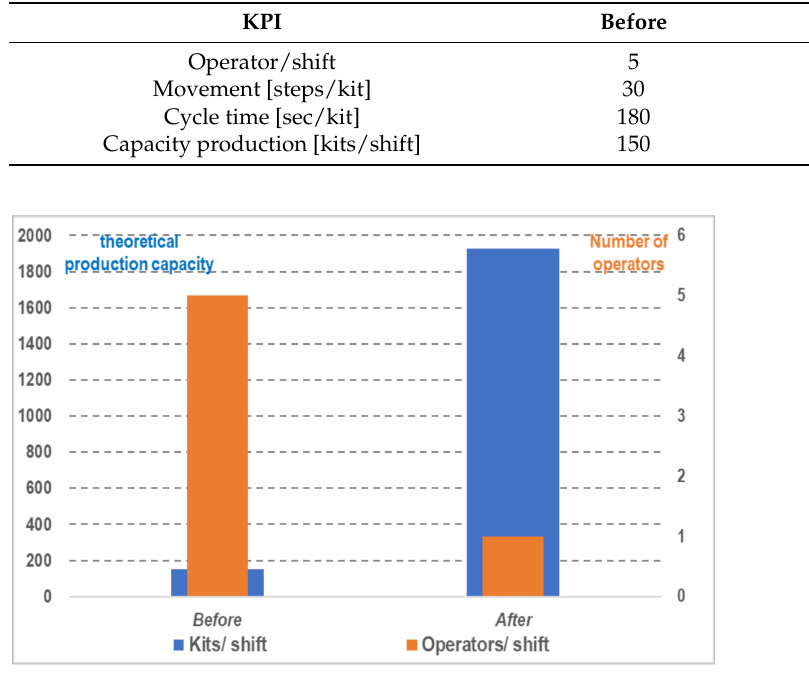
Figure 28. Operator numbers vs. production